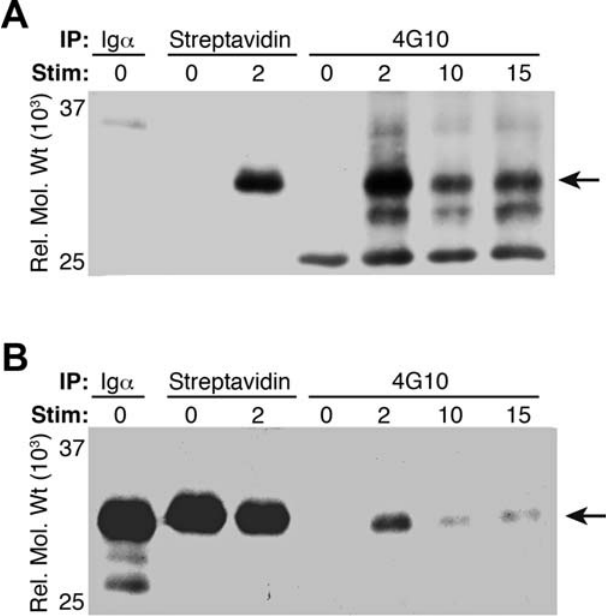
Figure 4. Only a Small Fraction of Ig a Is Phosphorylated following BCR Stimulation Aliquots of wild-type A20IIA1.6 cells were surface-biotinylated and then stimulated through the BCR for the indicated times. Following lysis, cells were precipitated with strepavidin, 4G10, or anti-Ig a antibodies. Precipitations were resolved by SDS-PAGE, transferred to nylon membrane and immunoblotted sequentially with 4G10 (A) and then anti-Ig a antibodies (B). Results of a typical experiment are presented ( n ¼ 3). Arrows denote Ig a . DOI: